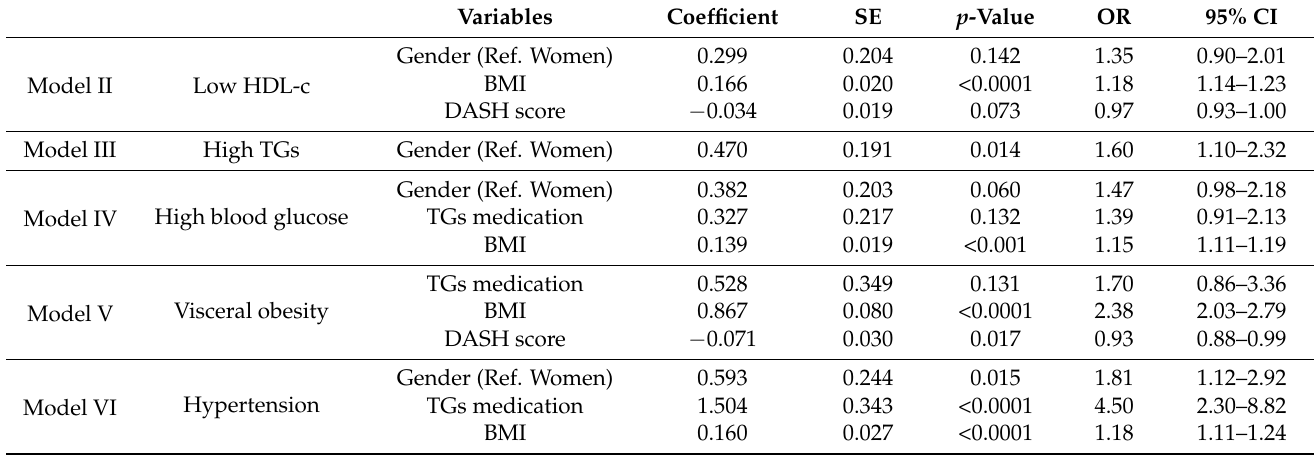
Table 4. Multivariate logistic regression analysis, odds ratios, and 95% confidence intervals for the prevalence of individual components of